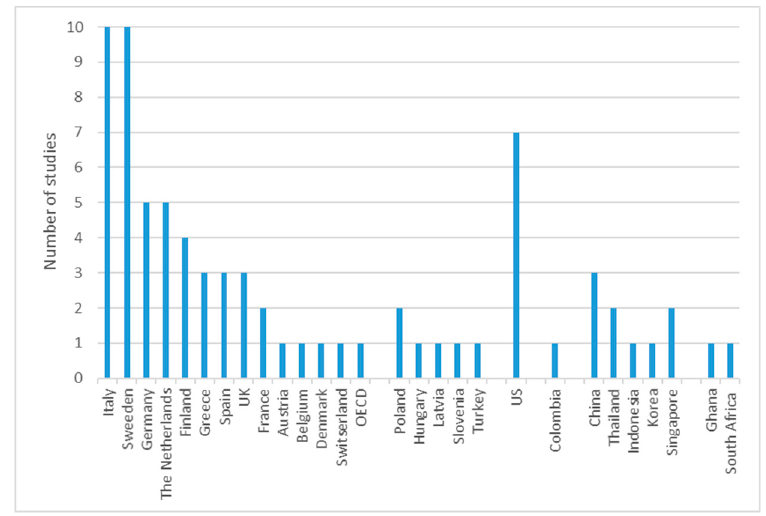
Figure 4. Distribution of empirical data by countries.